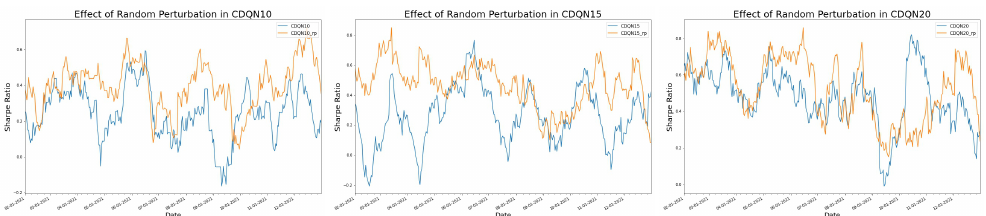
Figure 9. The effect of random perturbation measured by Sharpe ratio for BTC. ( a ) The left figure shows the comparison between the Sharpe ratio curves with or without the random perturbation technique in CDQN10. ( b ) The middle figure shows the comparison between the Sharpe ratio curves with or without the random perturbation technique in CDQN15. ( c ) The right figure shows the comparison between the Sharpe ratio curves with or without the random perturbation technique in